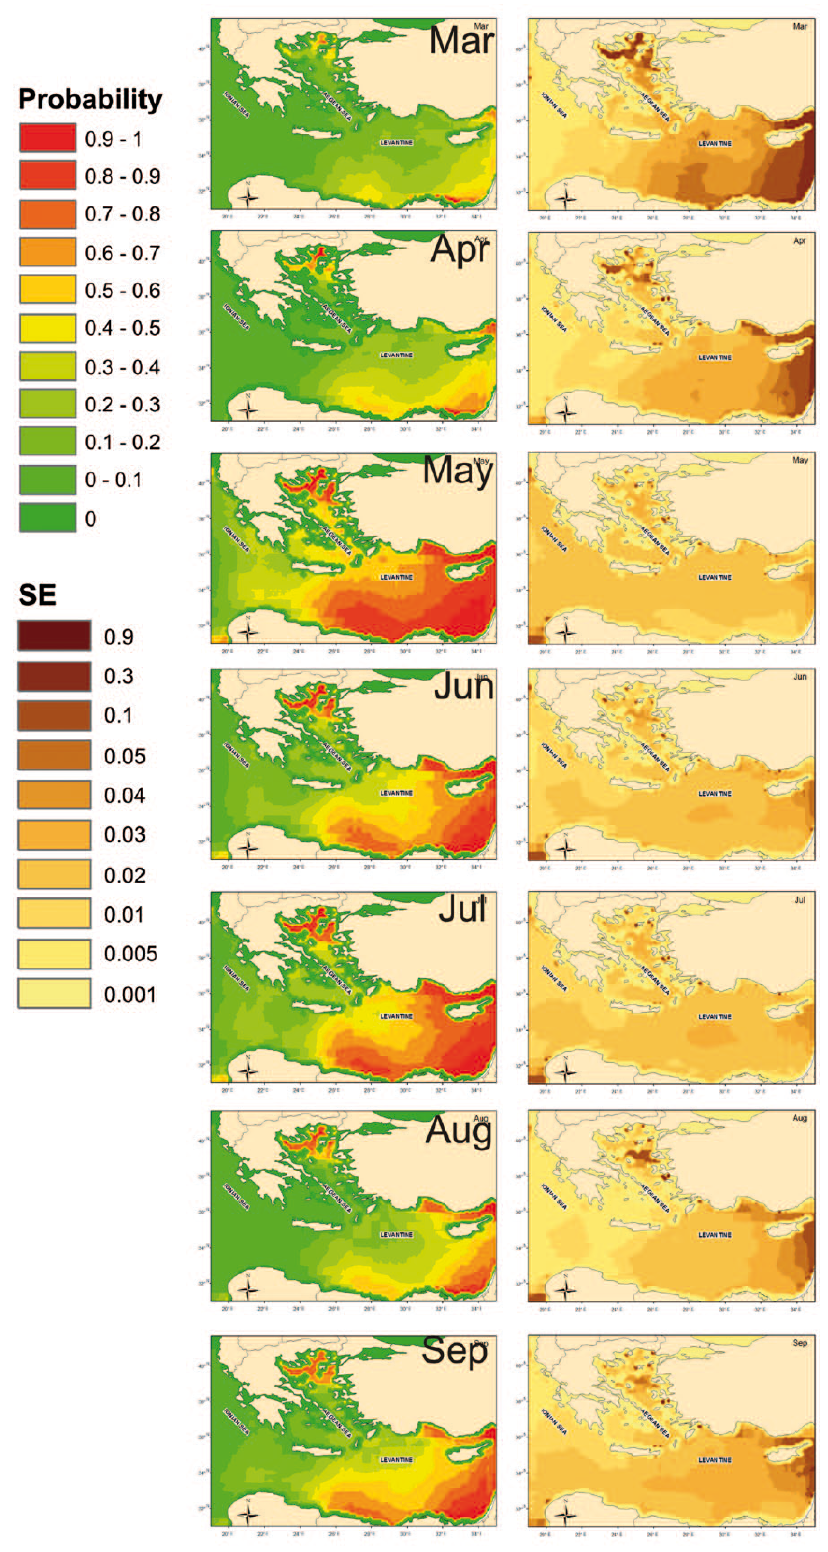
Fig . 4. – Predicted monthly probability of occurrence (presence-absence sub-model, left column) and corresponding standard errors (right column), for bluefin tunas in the eastern Mediterranean Sea in 1998-2005. (Predictions refer to a lunar index of 0.5 and American-type swordfish long-line fishing